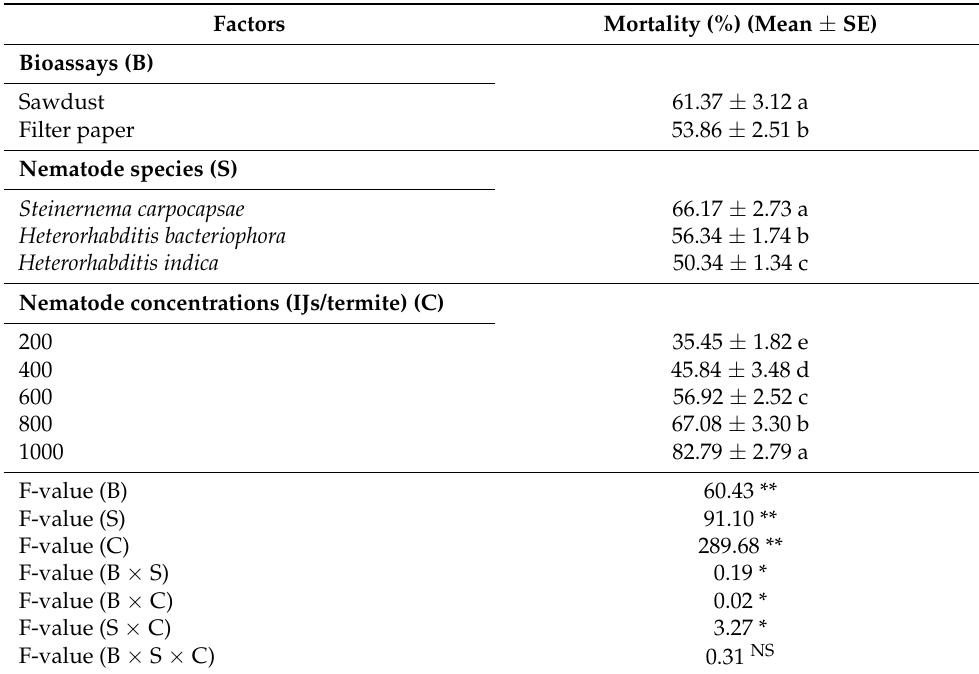
Table 2. Effect of bioassay methods (B), nematode species (S) and their concentrations (C) on mortality (%) of Odontotermes obesus workers kept under laboratory conditions at 26 ± 1 ◦